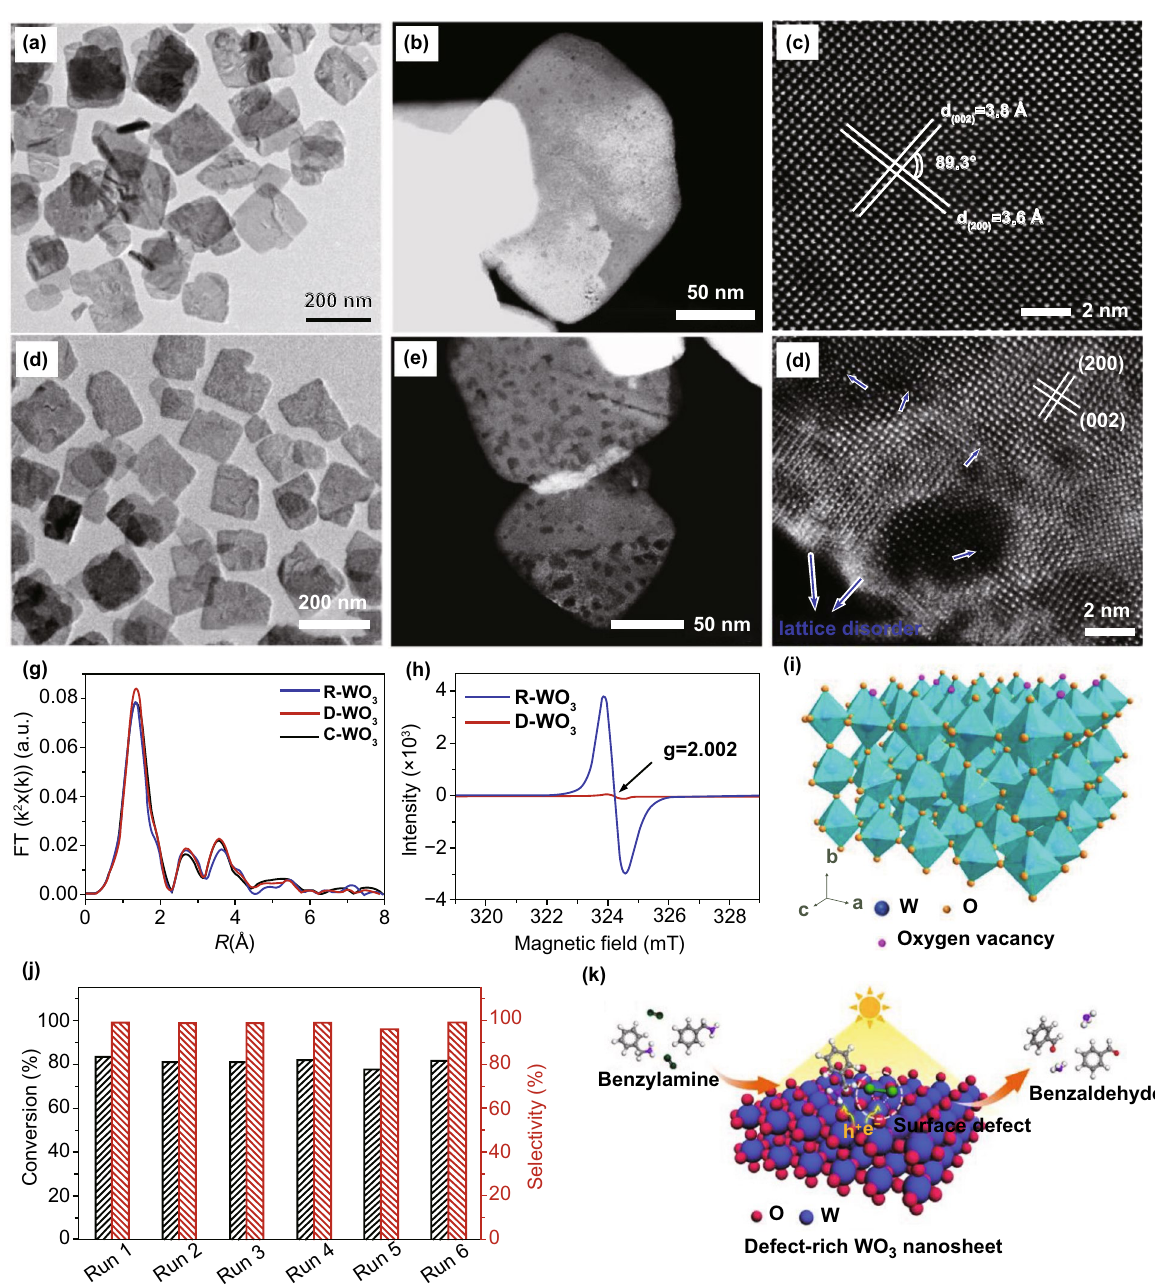
Fig. 21 a – f Morphological study. g Fourier transforms W L3‑edge EXAFS spectra with respect to commercial WO 3 . h ESR spectra at room temperature. i Scheme showing locations of V o in WO 3 lattice. j Cyclic analysis for defect‑rich WO 3 in catalytic aerobic coupling of benzylamine after irradiation with λ > 400 nm at 298 K. k Scheme shows total light‑driven catalytic reaction route. Adapted with permission from Ref.